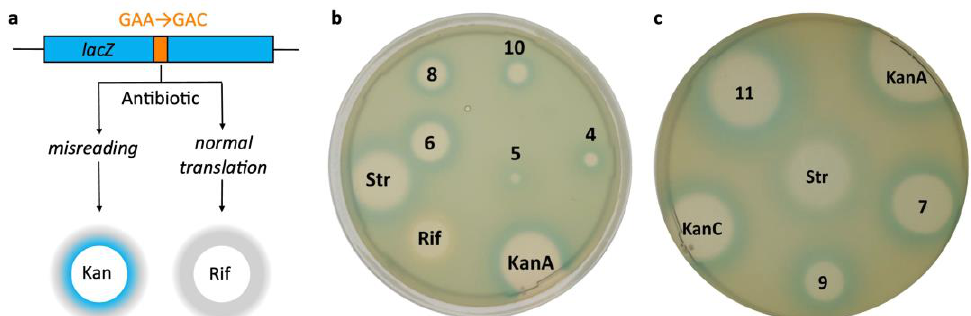
Figure 3. Kanamycin and its derivatives increase the misreading of 537 codon GAC (Asp) of the β -galactosidase gene by GlutRNA. ( a )—schematic depicting the principle of the method. If an antibiotic causes decoding errors, GAC is decoded as GAA, a β -galactosidase is synthesized which cleaves the X-Gal substrate, causing indigo blue staining. Otherwise, no functional protein is formed. ( b , c ) — results of the test for compounds 4 – 11 . KANA — Kanamycin A; KanC — Kanamycin